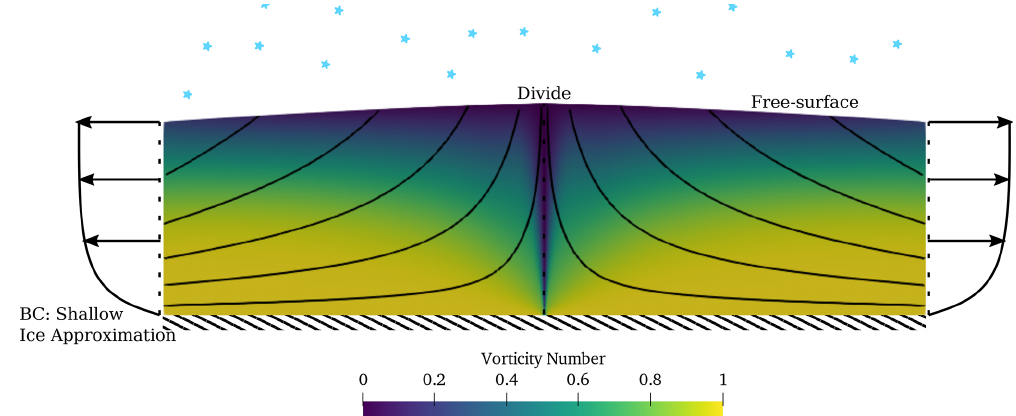
Figure 3. The vorticity number for ice flowing at a divide, showing a range from 0 to 1. The problem setup is from Martín et al. (2009) with isotropic ice. The simulation has an aspect ratio of 20, but only the region from x = 0 to x = 10 H , where H is the height of model domain, is shown. The domain has the velocity from the shallow ice approximation imposed at the left and right boundaries, and the surface accumulation is set to match the outflow, corresponding to a steady state. No slip is imposed at the base and a free surface is assumed at the top. The vorticity number is shown, alongside streamlines. This flow was computed using a full-Stokes solver written in FEniCS (Martin Alnæs et al., 2015) with n = 3 and solved using Taylor–Hood elements.